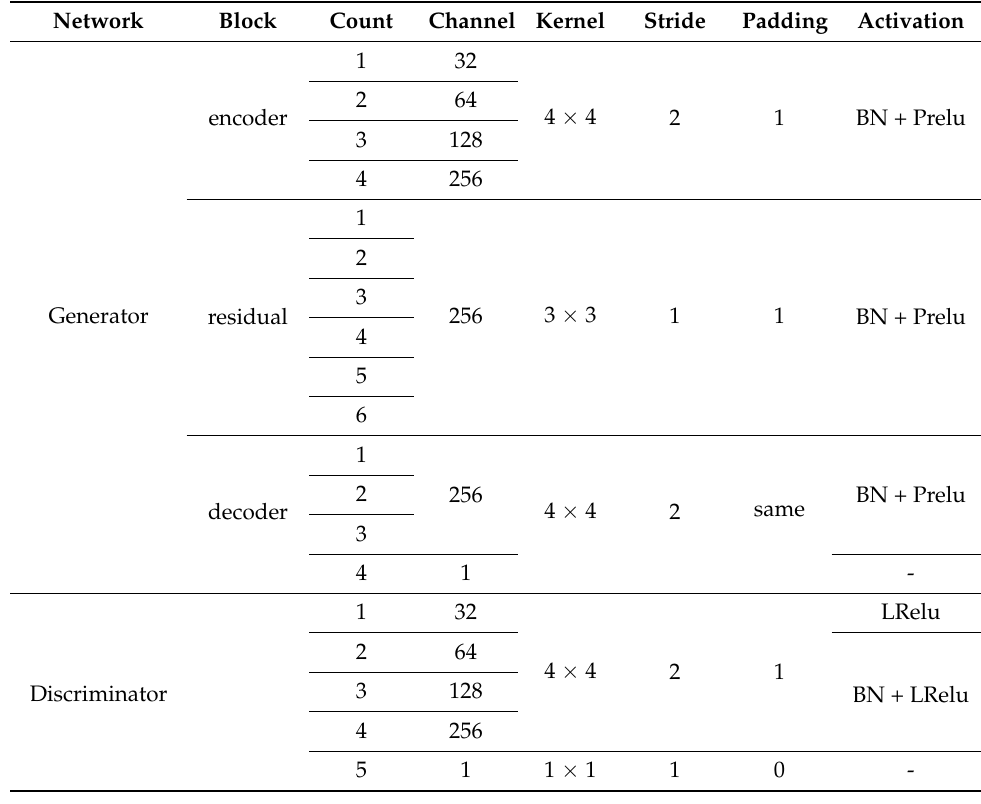
Table A1. Cycle-GAN.